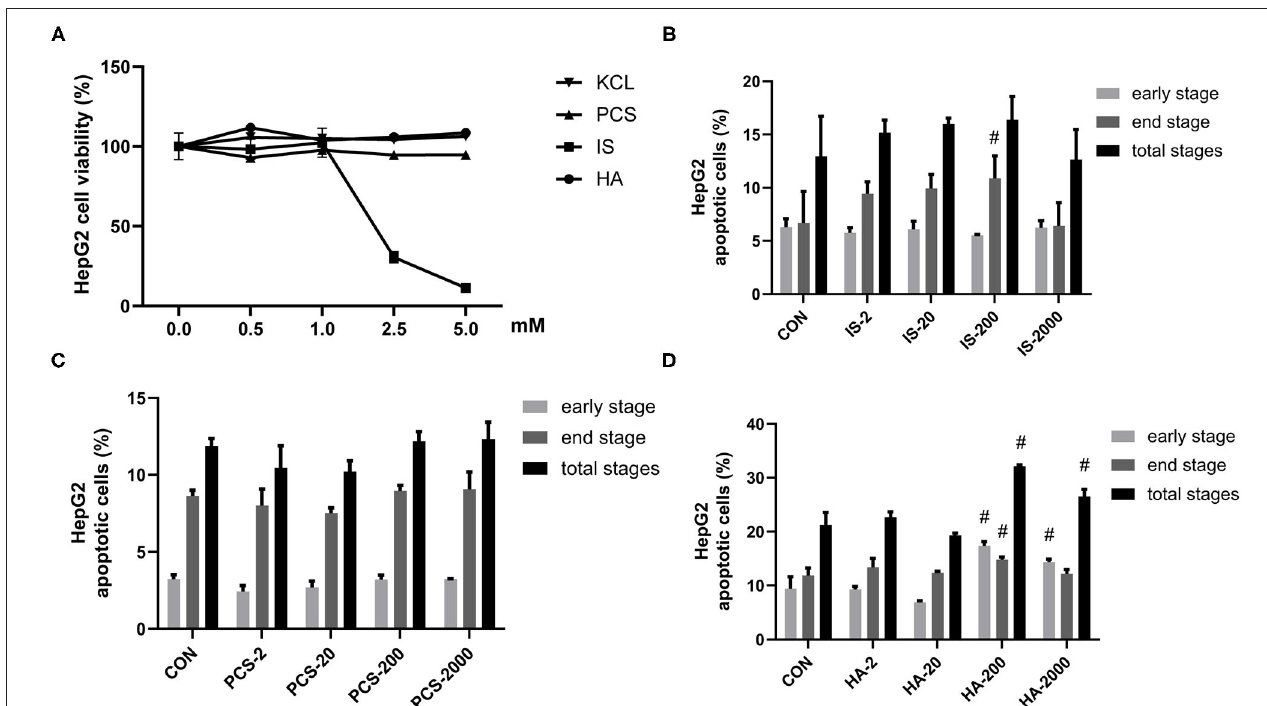
FIGURE 1 | Gut-derived protein-bound uremic toxins (PBUTs) induced apoptosis in HepG2 cells. (A) PBUTs cytotoxic effects. CCK8 assay was performed for HepG2 cells treated with p-cresol sulfate (PCS), indoxyl sulfate (IS), hippuric acid (HA), and KCL at doses of 0-5mM for 24h ( n = 3). (B) Effect of IS on HepG2 apoptosis ( n = 3). After 24h treatment, flow cytometry was performed on cells stained with annexin V-FITC and PI. CON, control. IS-2, 2 µ M IS treatment. IS-20, 20 µ M IS treatment. IS-200, 200 µ M IS treatment. IS-2000, 2000 µ M IS treatment. Group settings are the same with PCS (C) and HA (D) . (C) Effect of PCS on HepG2 apoptosis ( n = 3). (D) Effect of HA on HepG2 apoptosis ( n = 3). For all bar graphs, the data are the mean ± SD. # , P < 0. 05 vs. CON group. The significant difference was assessed using the one-way ANOVA followed by LSD